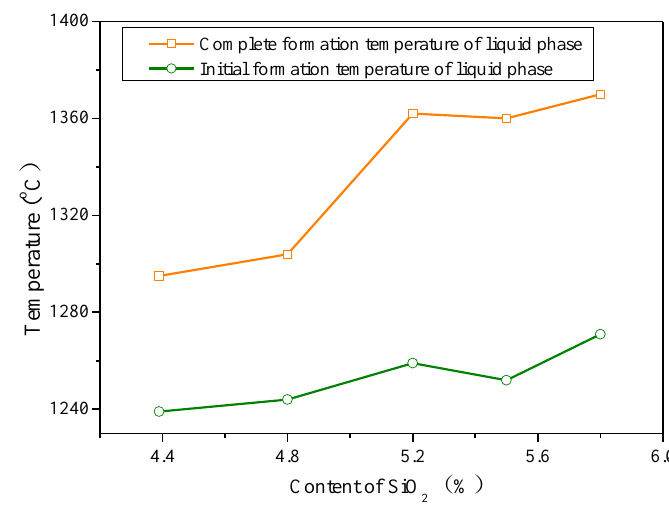
Figure 12. Influence of SiO 2 content on the formation temperature of the liquid phase.